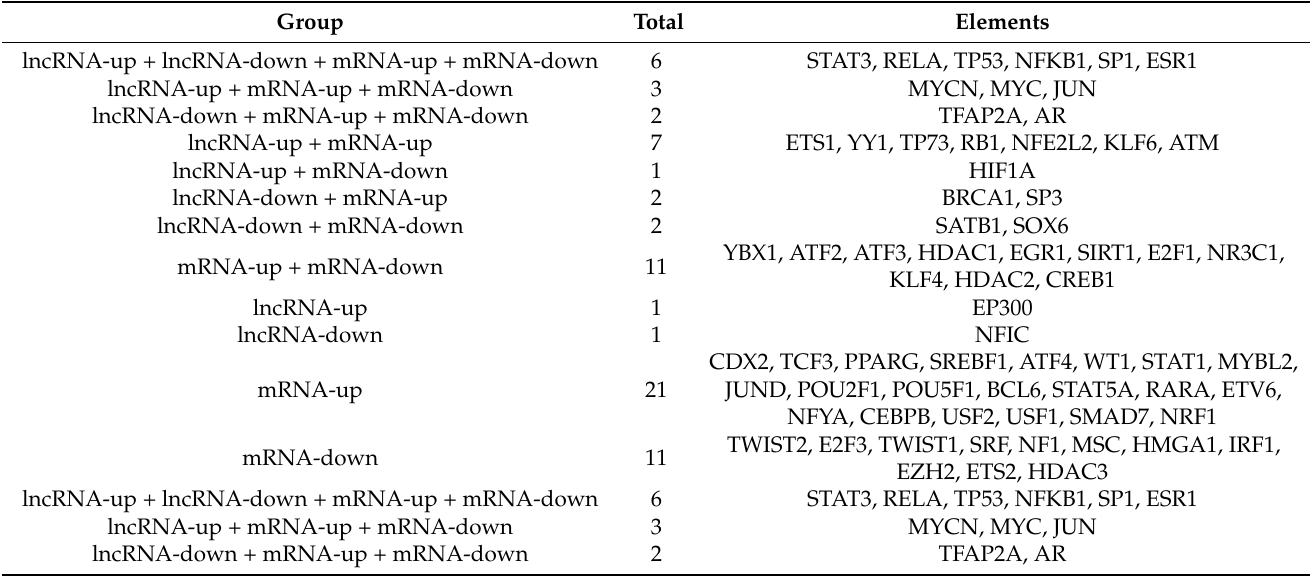
Table 2. Transcription factors of significantly changed transcripts in HPNE predicted by TRRUST (Venn diagram in Figure 5B).